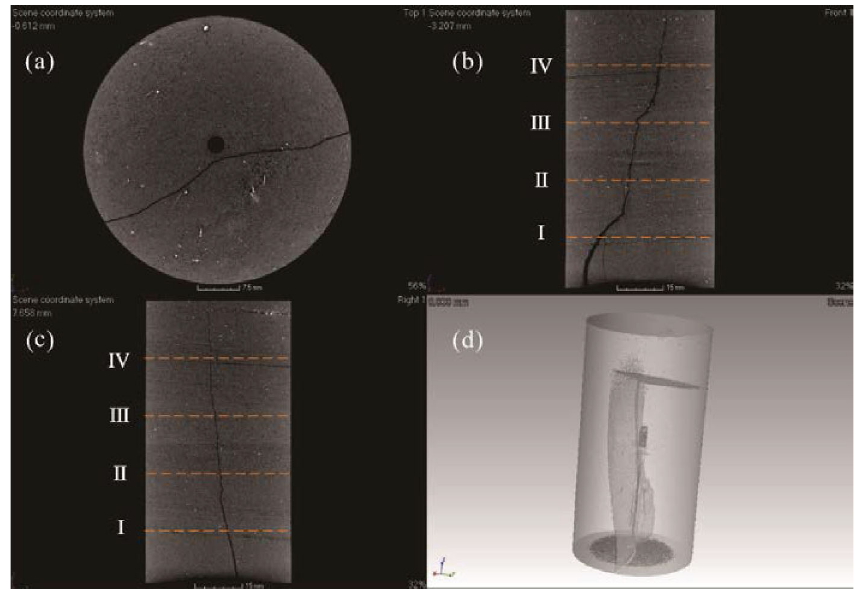
Figure 9: Micro-CT scanning results of rock sample T2. (a) A horizontal slice. (b, c) Two vertical slices near the sample center and are cut roughly perpendicular to the fractures, and I-IV correspond to the horizontal slices at heights of 20mm, 40 mm, 60mm, and 80mm. (d) The 3D view of the scanning